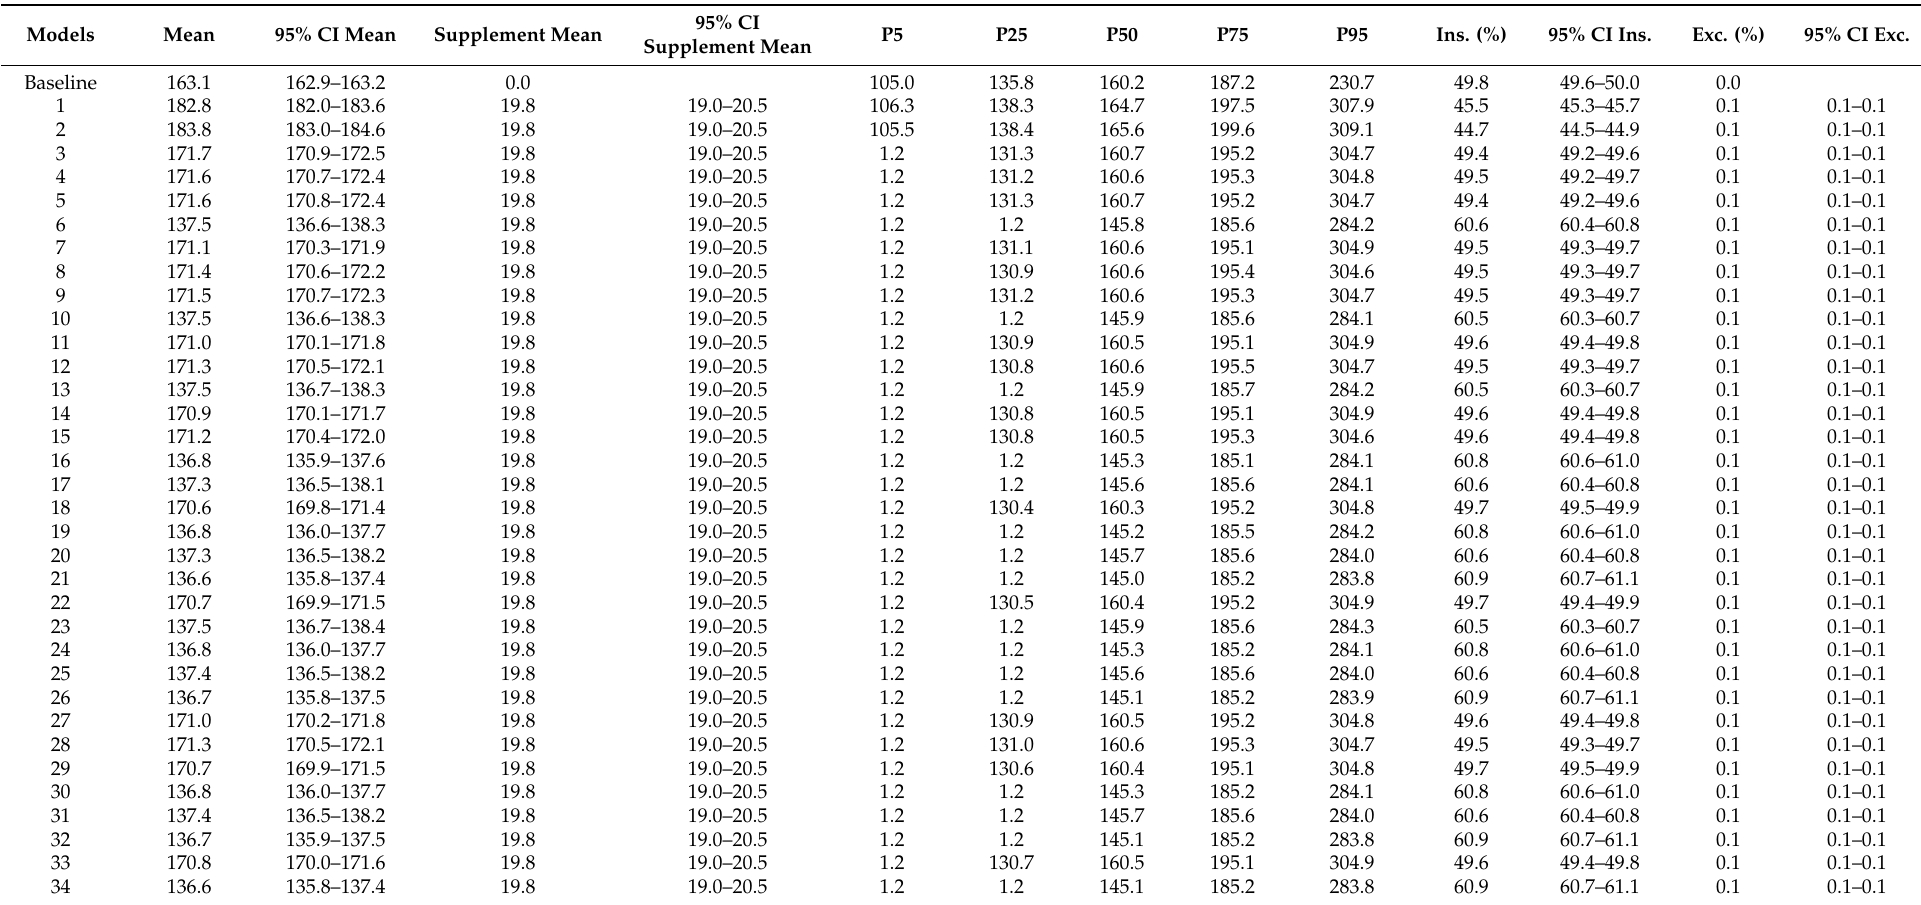
Table 3. Usual iodine intake and prevalence of inadequate intake of pregnant women according to Models, Multicenter Study of Iodine Deficiency, Brazil,